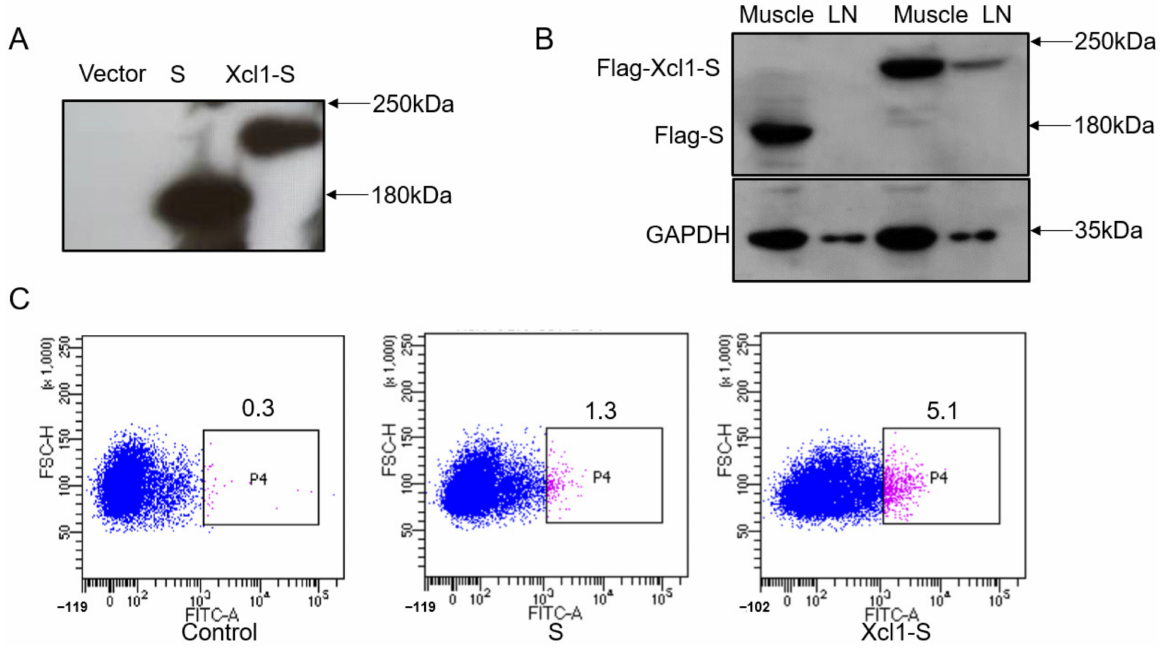
Figure 2. Identification of the expression and function of the DNA vaccine constructs. ( A ) Flag-tagged Xcl1-S and S were overexpressed in HEK293T cells and analyzed by immunoblotting using antibodies against Flag to indicate Xcl1-S and S, respectively. ( B ) Immunoblots confirming the distribution of Xcl1-S and in muscle and lymph nodes (LN) from plasmid-injected mice. Protein extracts from the lymph nodes and muscles of one representative pair of mice were tested with an anti-Flag antibody. ( C ) Binding of Flag-tagged Xcl1-S and S proteins to DCs. DCs isolated from the mouse spleen with CD11c beads were incubated with lysates from 293T cells expressing the Xcl1-S and S